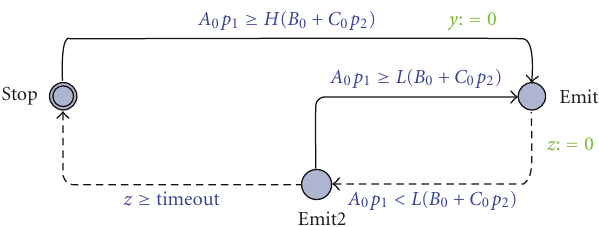
Figure 4: The observer implementing whether or not the connec- tion can be established or maintained.